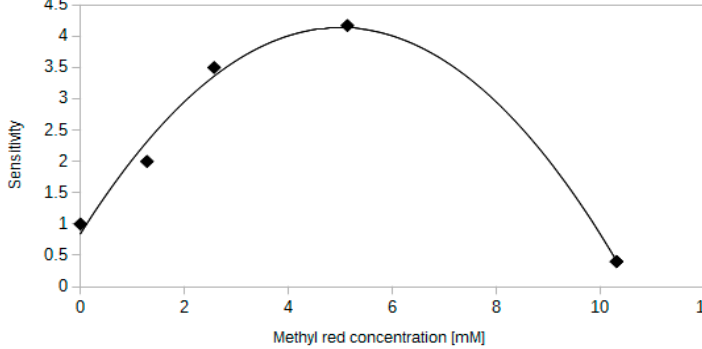
Figure 5. Dependence between the sensitivity and the concentration of methyl red in the sensing layer. Each sample has the same geometrical parameters and the same layer thickness.